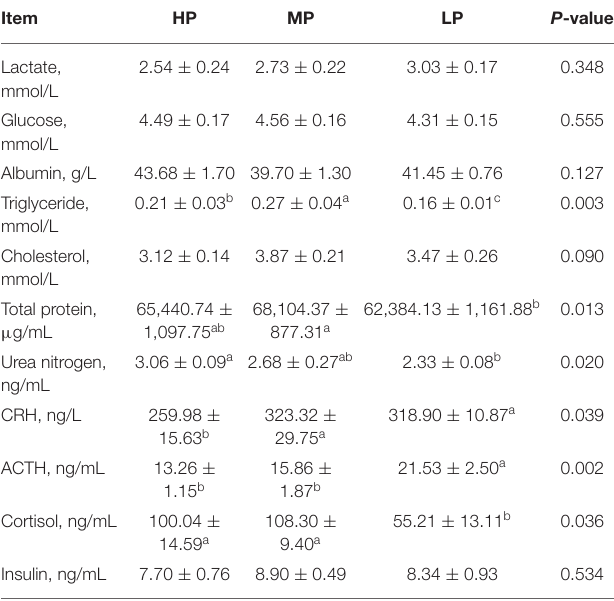
TABLE 6 | Effect of low protein diet on plasma biochemical index and hormone levels in finishing pig.